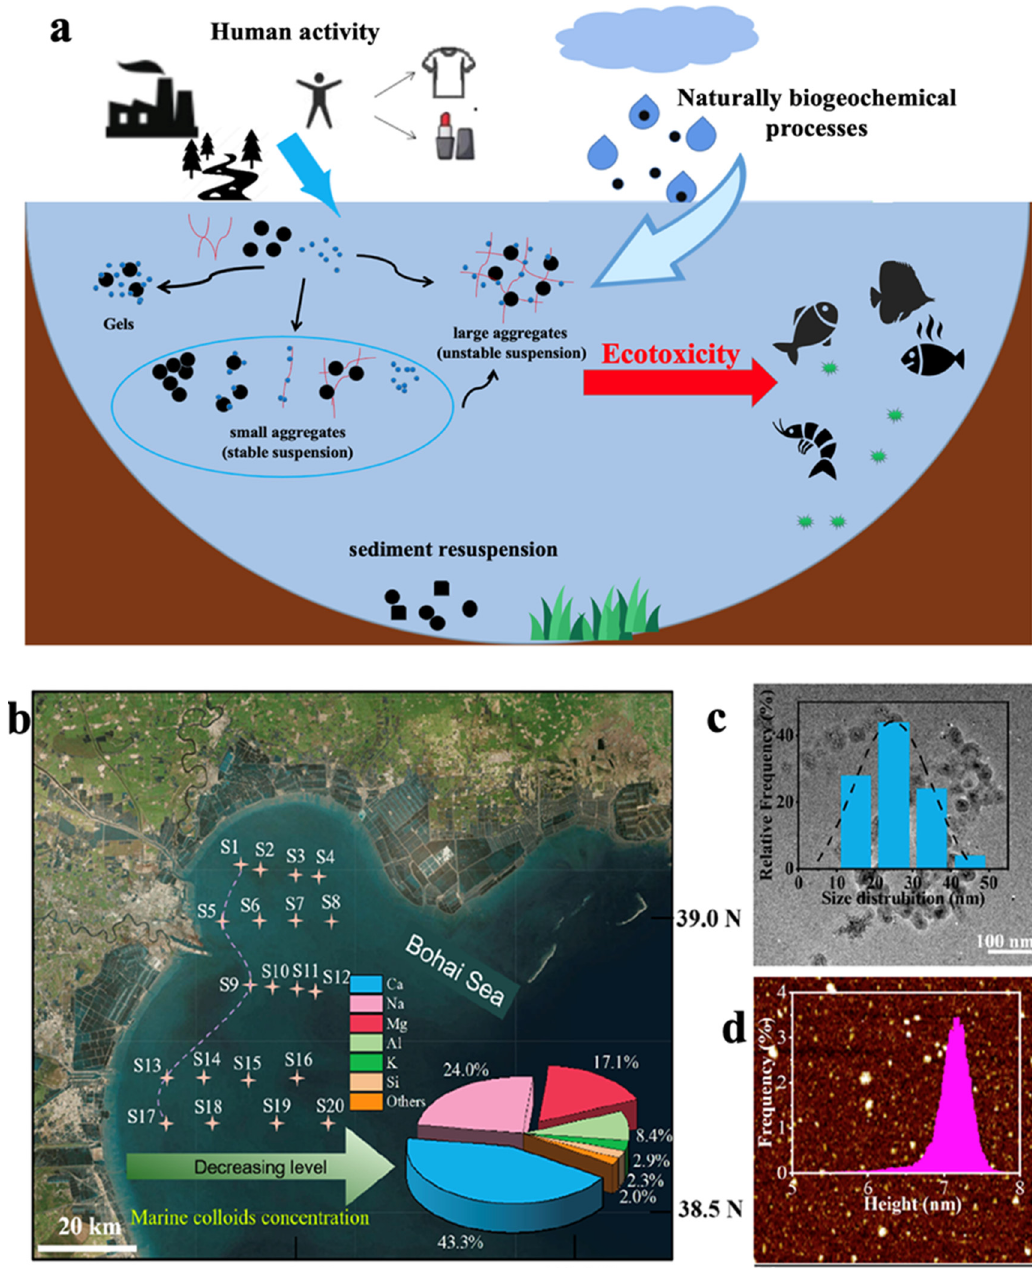
Figure 1. Formation, distribution, characterization of Ncs. ( a ) Schematic representation of the main source of Ncs in aquatic environment (small blue points: fulvic type material, dark circles: inorganic colloids, red lines: biopolymers). ( b ) Location of samples and marine colloids concentration. ( c ) Typical TEM images ( n = 50) of marine colloids and size distribution. ( d ) Typical AFM images ( n = 50) of marine colloids and height distribution. Reprinted (adapted) with permission from (Kang et al.)